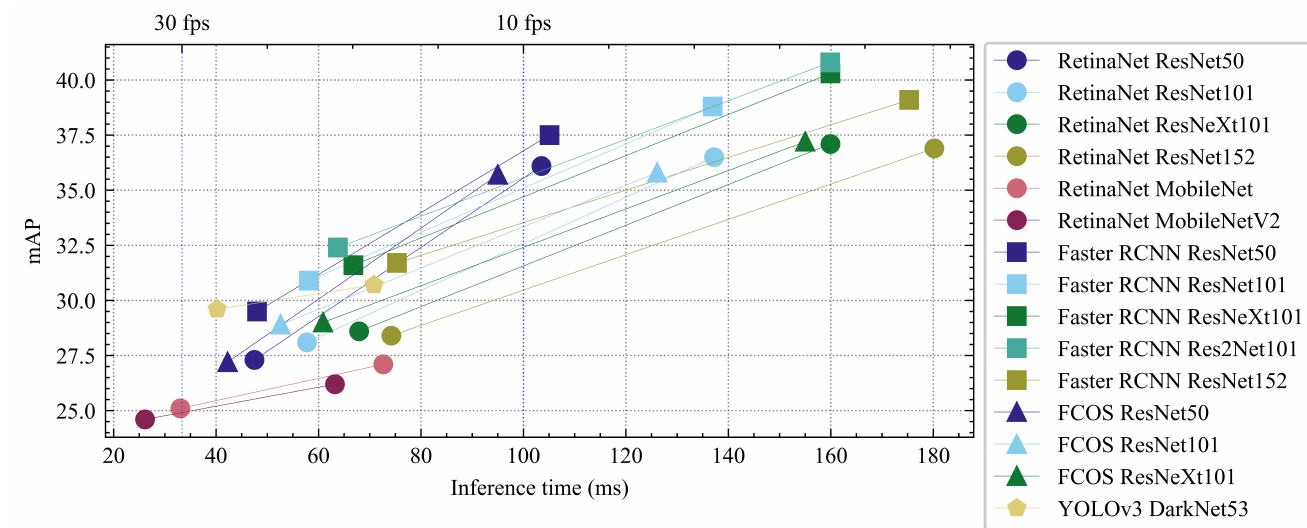
Figure 4. Inference time versus accuracy of low and high resolution models with different architectures and feature extractors. Low resolution models are always the left-most point of each